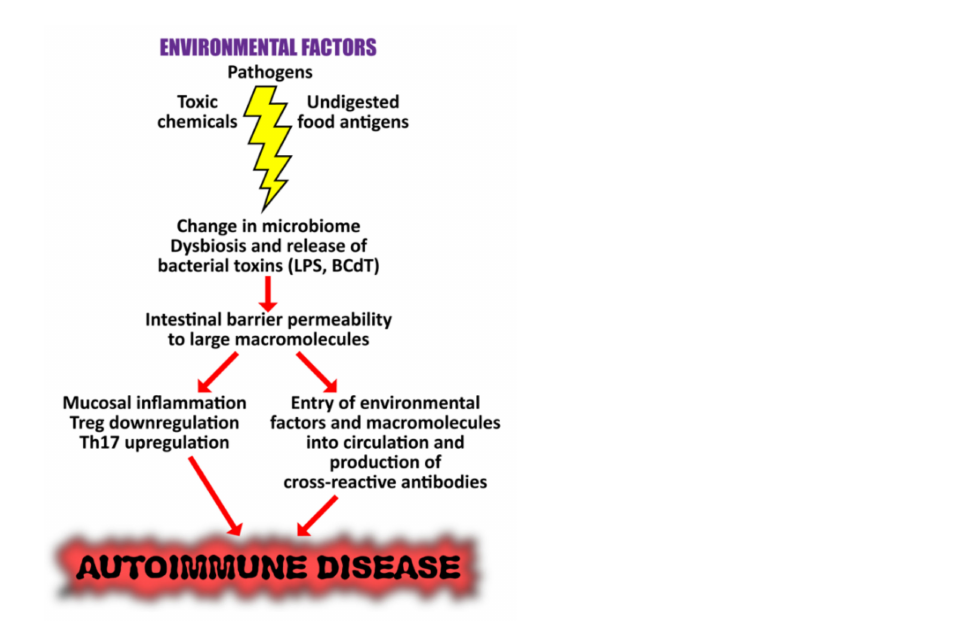
Figure 15. Proposed mechanisms by which microbiome dysbiosis may induce autoimmune dis- ease. Environmental factors such as toxic chemicals, food antigens, and pathogens can affect mu- cosal inflammation, intestinal barrier function, and immunity, causing increased translocation of bacteria or their metabolites, such as circulating endotoxin LPS. This promotes systemic aberrant anti-inflammatory responses, eventually resulting in autoimmune